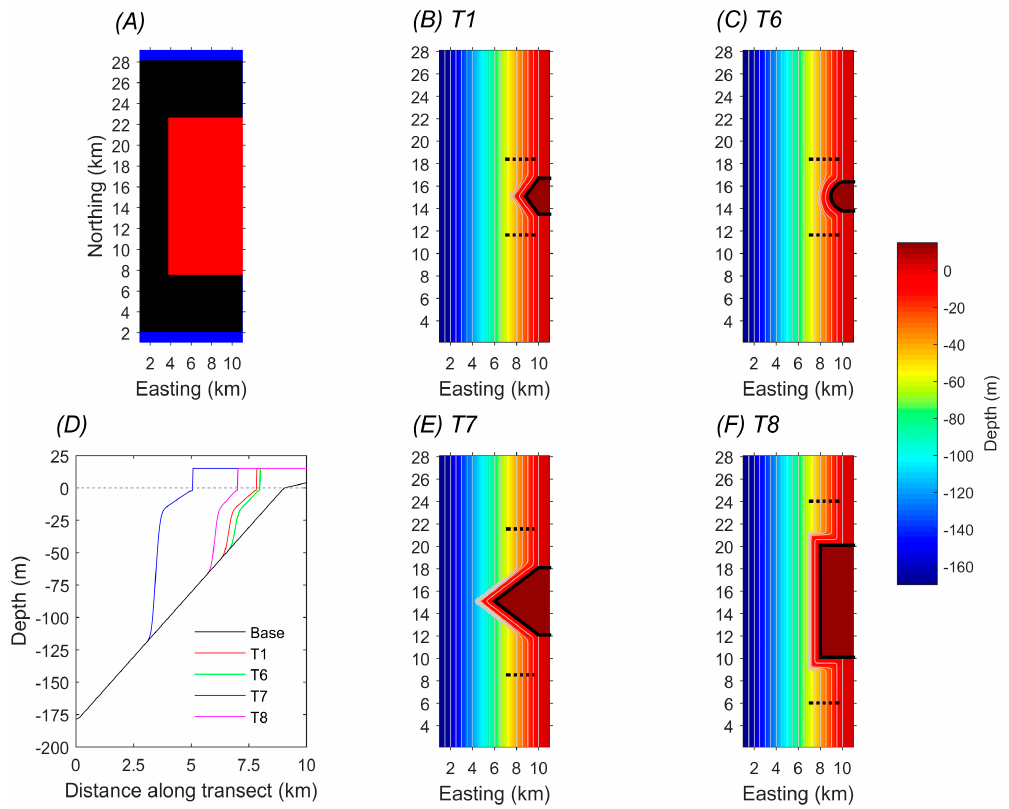
Figure 3. Grids, bathymetry, and cross-shore profiles used in modeling study. ( A ) Computational grids for SWAN1 (blue), FLOW (black), and SWAN2 (red). Bathymetry and plan view of headlands shown with the headland noted by black line, 2.5-km long cross-shore transects at the headland shoulders as dashed lines, and contours at 10-m intervals for T1 ( B ), T6 ( C ), T7 ( E ), and T8 ( F ). ( D ) Cross-shore profiles at the apex of the headlands showing the protrusion into the flow field compared to the base line located away from the headland. Table 3. Design of idealized headlands based on George, Largier, Storlazzi, and Barnard [27] (G2015) Classification.